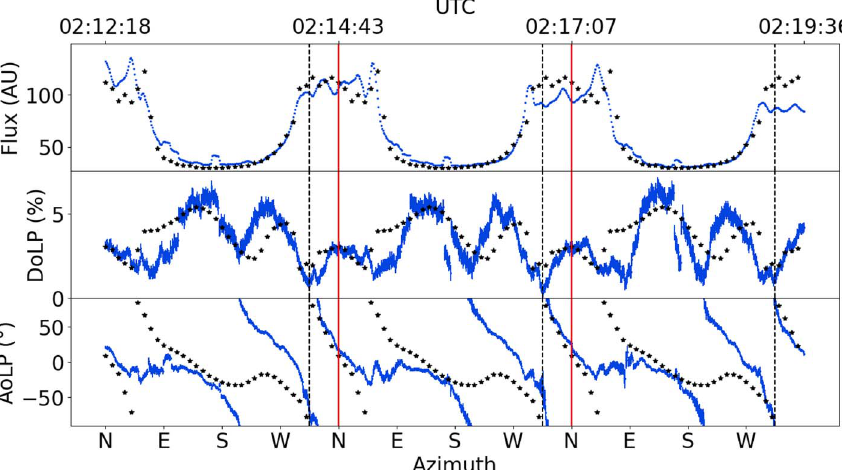
Fig. 12. 3 almucantar observations at 427.8 ± 5 nm (March 8, 2019): observations (in blue) and predictions for the model that best fi ts the data (Black stars H ). The model is a linear combination of ground and sky (including albedo) for a 6% polarised sky emission in a direction de fi ned by an azimuth of 50 (cid:3) and 10 (cid:3) elevation (see text for details). The dashed vertical black line indicates the direction of Skibotn. The picture of the sky at 557.7 nm is shown in Appendix